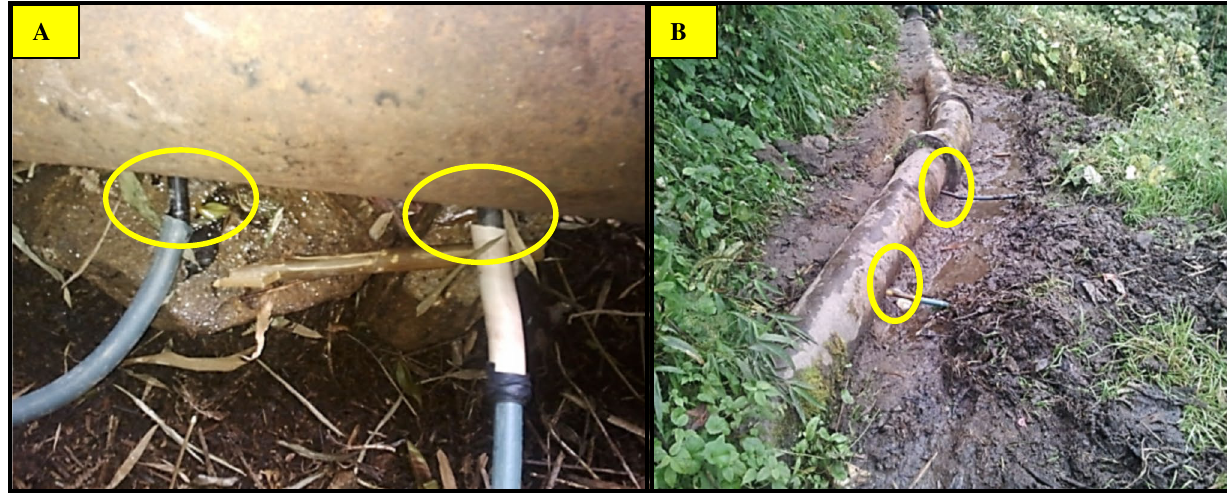
Fig. 7 A and B : Illegal tapping of water in the main transmission line at Aloobari and Ganeshgram (Ward no. 1 & 14). Source : DM